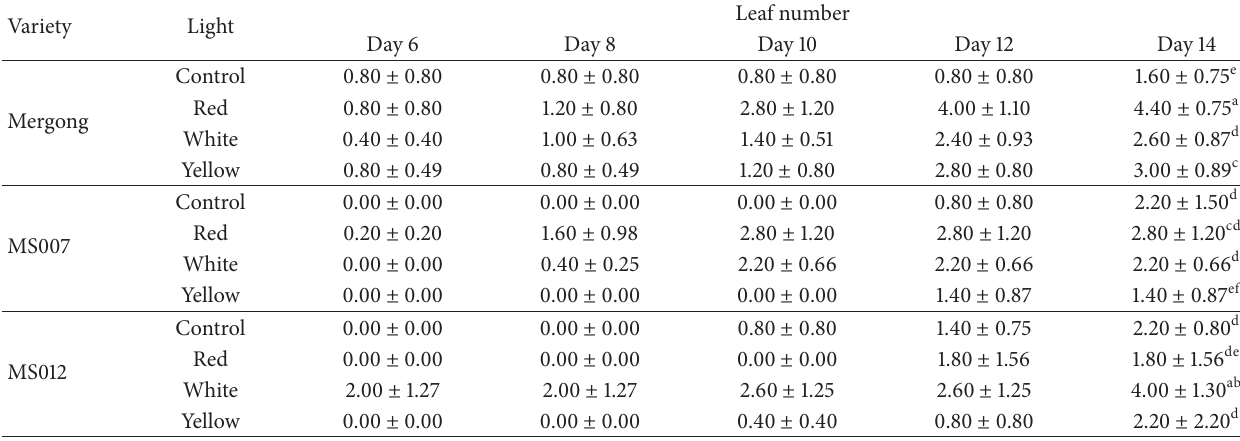
Table 11: Mean leaf number of three varieties treated with red, white, and yellow lights from day 6 to day 14 in mist-chamber propagation box.